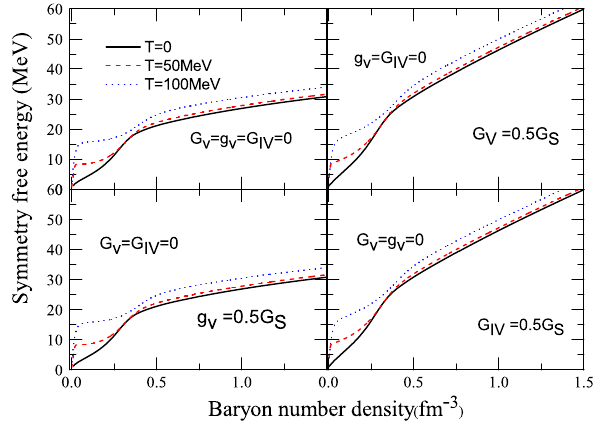
Fig. 1 Quark matter symmetry free energy within different vector interaction from NJL